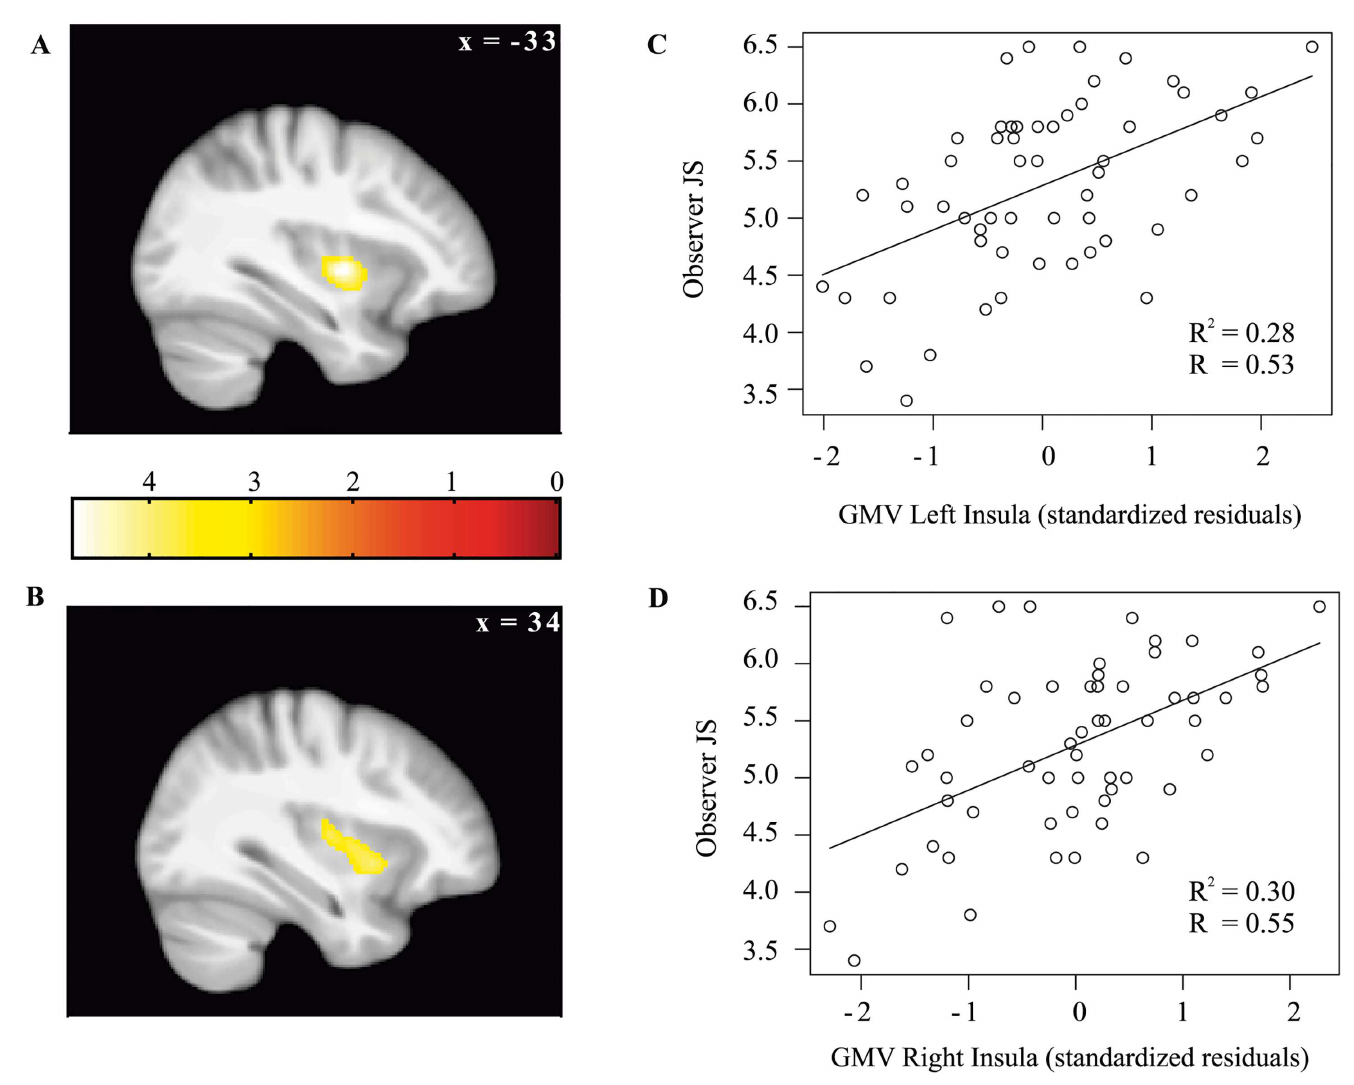
Fig 1. Observer Justice Sensitivity is positively associated with insular gray matter volume. The gray matter volume (GMV) is adjustedfor age and brain-size. (A) Effect shown in sagittal view of the left insula(at p < 0.05, FWE-corrected for the whole brain, for displaypurposedepictedat p < 0.001 uncorrected). (C) Scatter plot of Observer Justice Sensitivity(JS) againstthe z-standardized GMV of the significantcluster in the left insula. (B) Same as (A) for right insula. (D) Same as (C) for right insula.